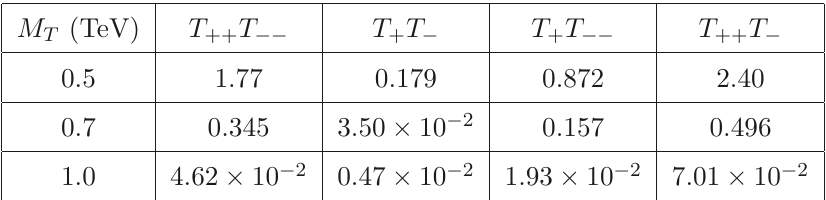
Table 5 . Charged Triplet bosons pair production cross sections(in fb ) at the LHC14. Here we have neglected effects from H 0 and T 0 since it is small and give subleading ℜ ℜ